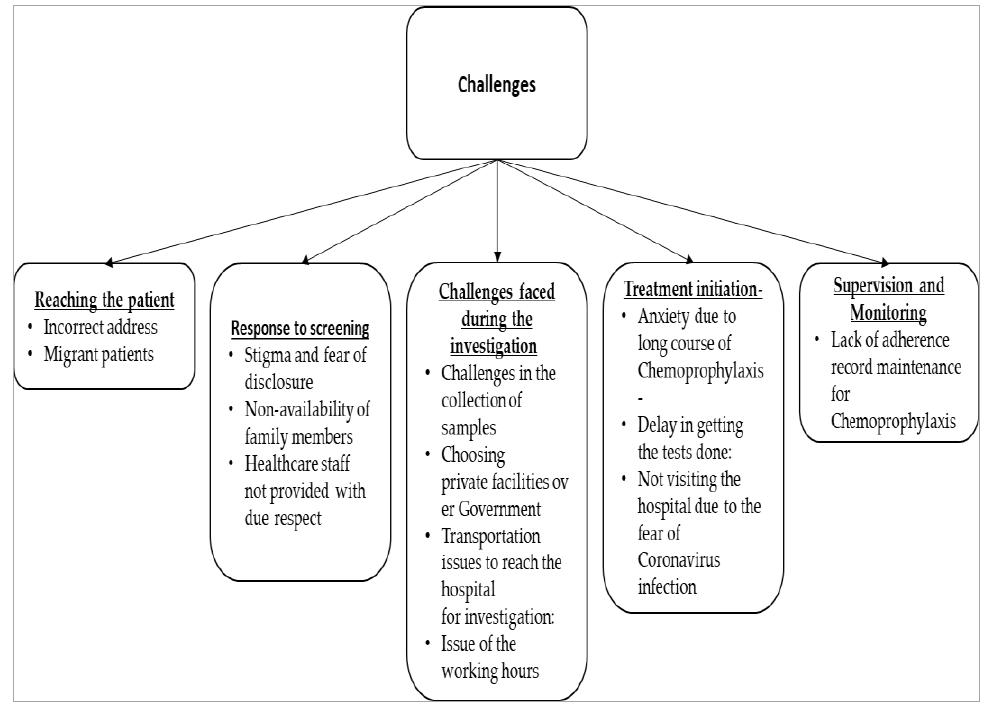
Figure 2. Depicting the key challenges faced by the healthcare staff.